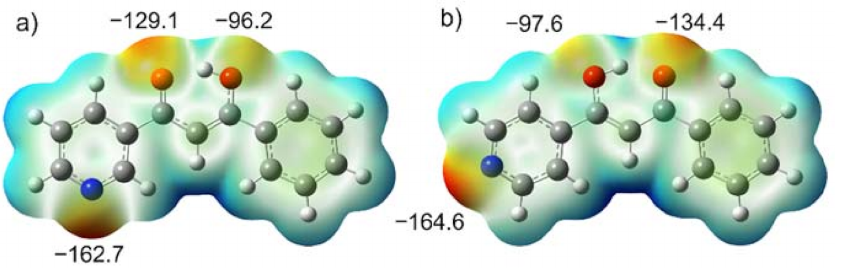
Figure 3. Molecular electrostatic potential mapped on the total electron density surface (0.002 e A − 3 ) of ( a ) anti - b3pm , ( b ) b4pm . All values are in kJ mol − 1 e − 1 .